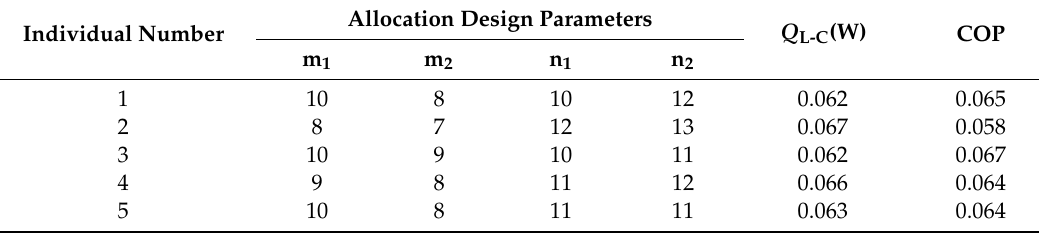
Table A1. The value of search variables and performance metrics for the improved CTE system.